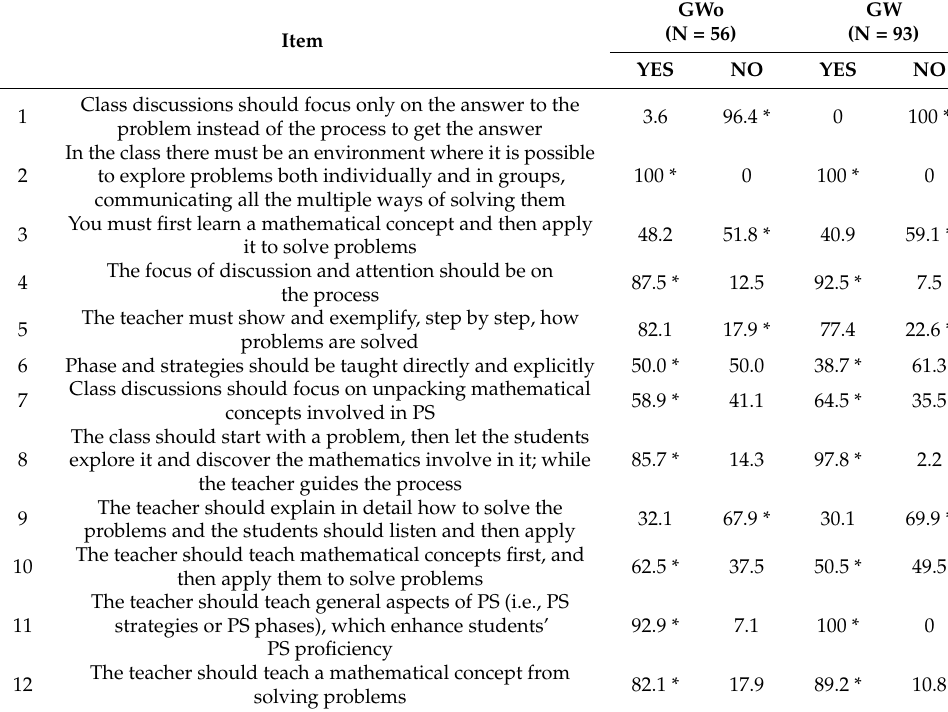
Table 4. Percentages of responses of knowledge of PS teaching